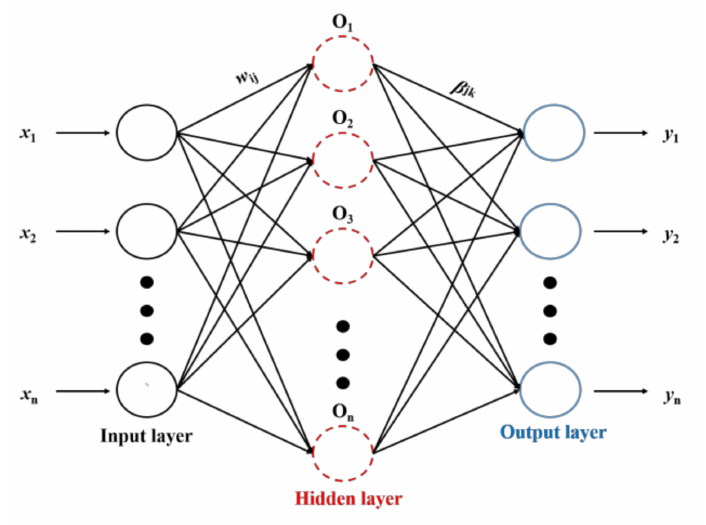
Figure 7. A typical model of